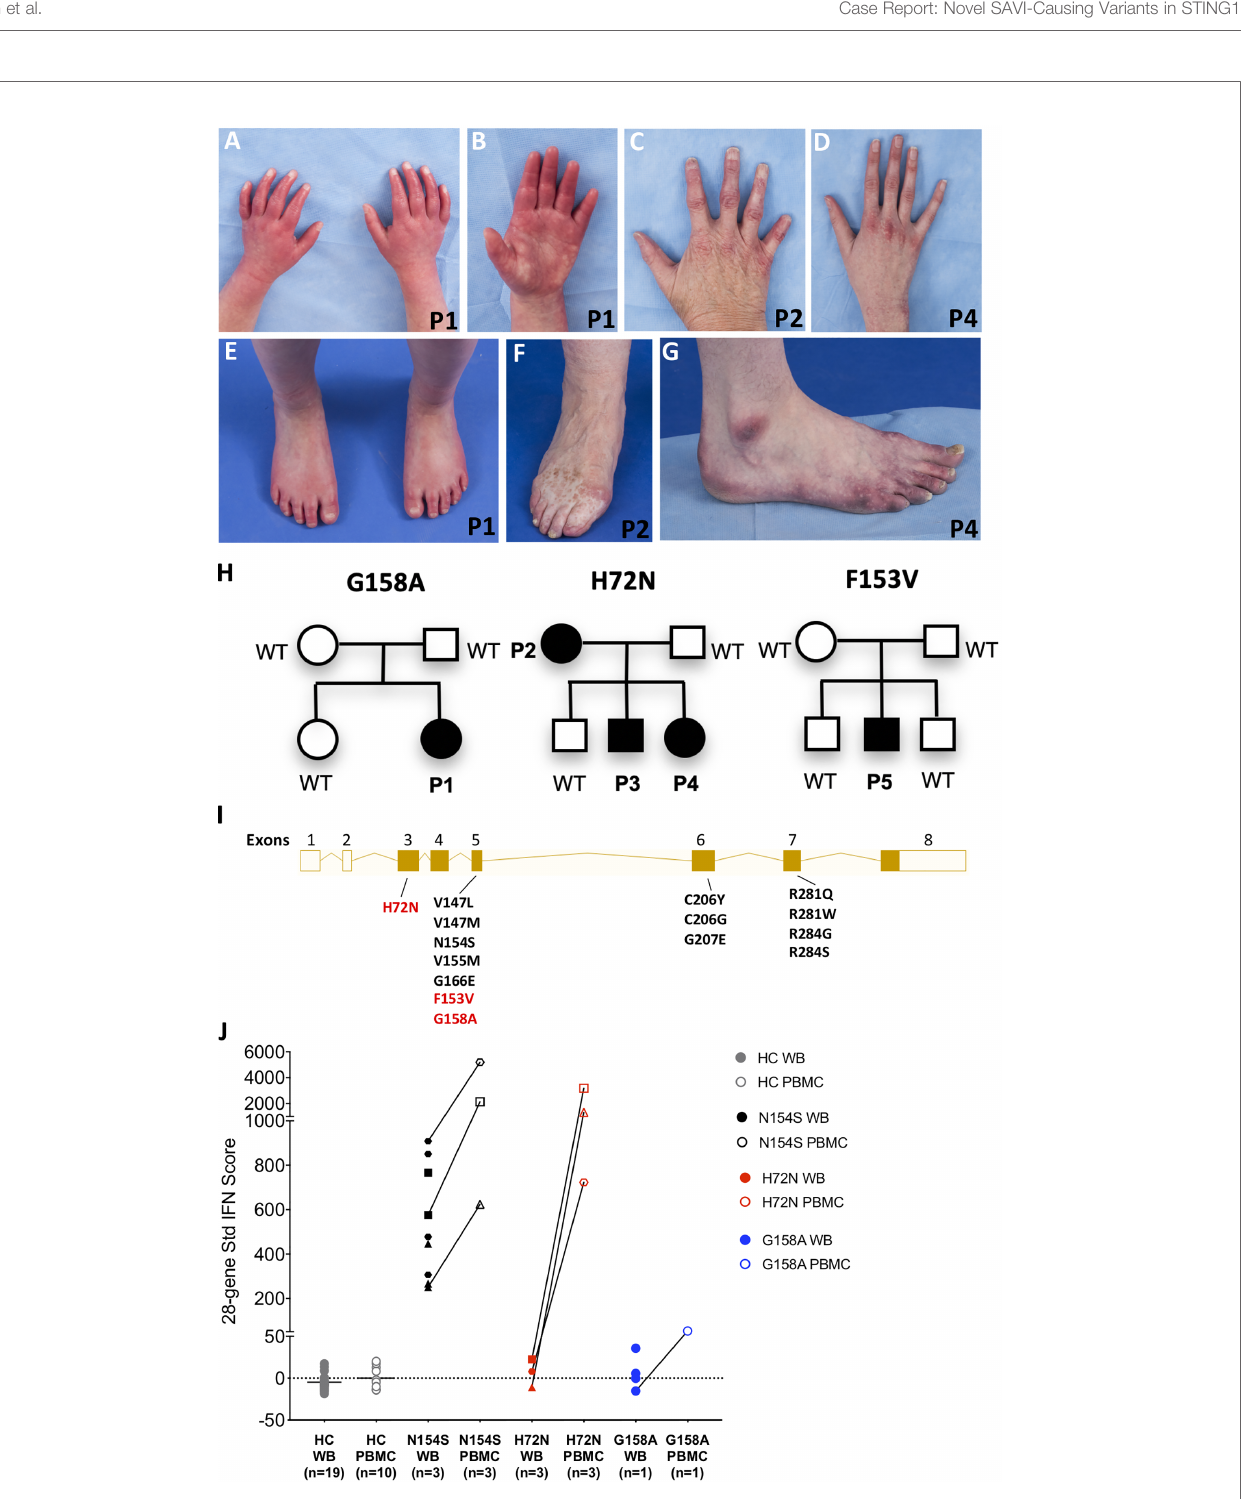
FIGURE 1 | Three novel variants in STING1 cause SAVI. (A – D) Erythematous lesions of the hands and tapered fi ngers in Patient 1 (A, B) , Patient 2 (C) and Patient 4 (D) . (E – G) Erythematous rash on the feet and tapered toes in Patient 1 (E) , with similar lesions and tissue loss of the feet in Patient 2 (F) and Patient 4 (G) . Patient number is depicted on the bottom right corner of each picture. (H) Pedigree charts. Solid symbols represent affected individuals; open symbols, unaffected individuals. P1-P5: patients, WT: wild type. (I) Exon locations of all SAVI-causing STING1 variants. Open boxes represent non-coding exons, solid boxes represent coding exons, while lines represent introns. Previously reported variants are in black and the three novel variants in red. Transcript diagram was obtained from ENSEMBL (www.ensembl.org). (J) 28-gene Interferon (IFN) scores from whole blood (WB) and peripheral blood mononuclear cells (PBMCs). Solid symbols indicate WB and open symbols indicate PBMCs. Healthy control (HC) samples included 19 WB and 10 PBMCs. SAVI patients with N154S mutation (n=3) in black, family members with H72N mutation (n=3) in red, and patient with G158A mutation (n=1) in blue. Paired PBMC and WB IFN scores from the same time point are connected by a line. Each patient with SAVI is represented by a different